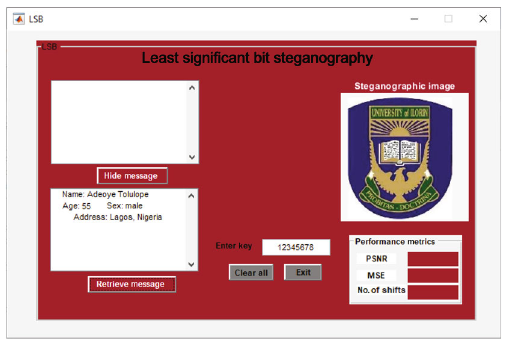
Figure 7: Interface of the extraction phase. Table 1: Evaluation of the proposed system. Samples